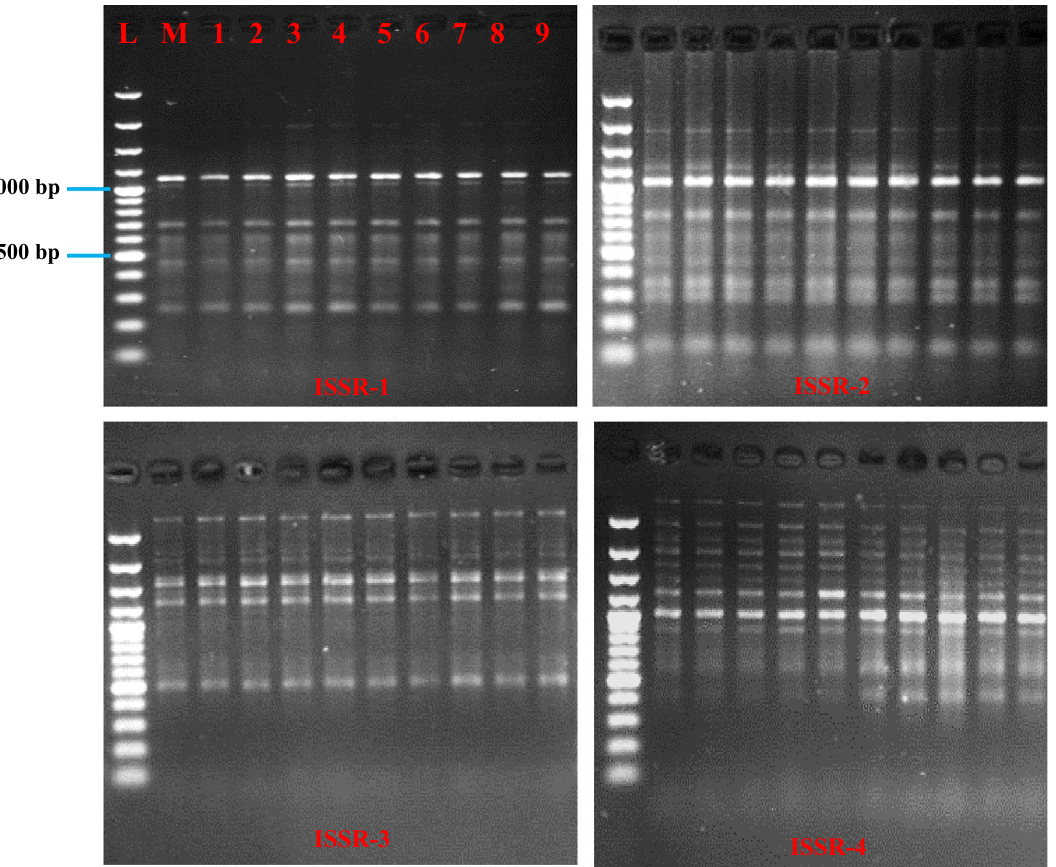
Figure 2. ISSR profiles generated by PCR amplification. Lane L: molecular marker (100 bp); lane M: mother plant; lane 1–9 in vitro raised